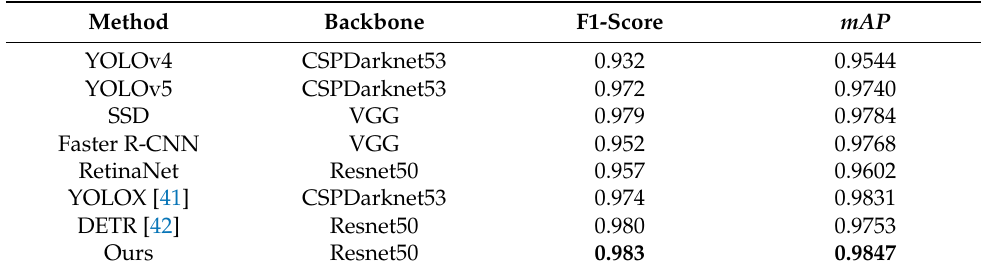
Table 6. Comparison of the accuracy of commodity detection with different algorithms.